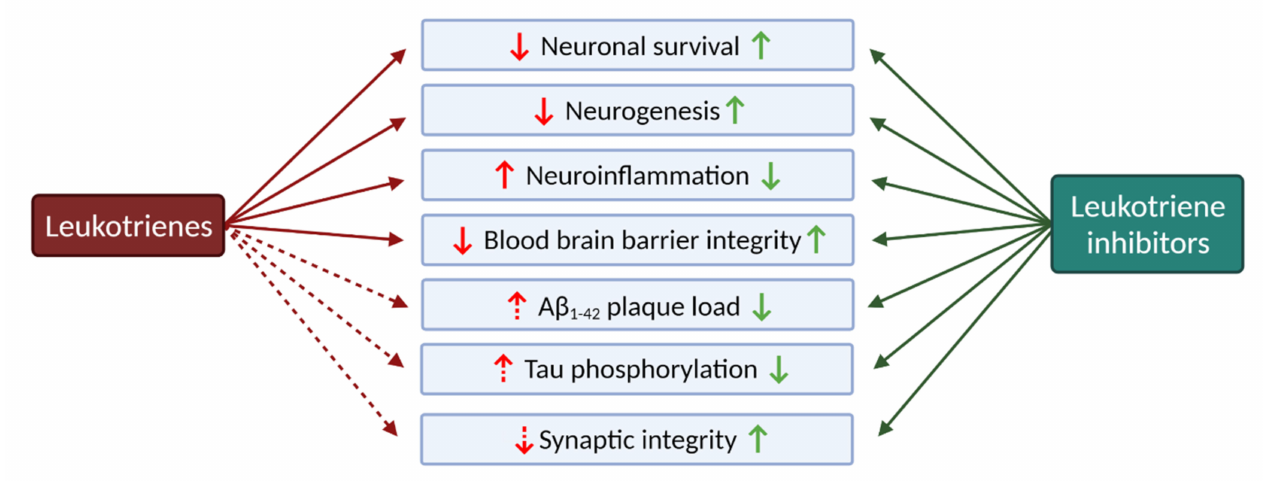
Figure 4. Leukotrienes in the central nervous system: a pleiotropic effect. Broken lines symbolize putative actions of leukotriene signalling that require further investigations. Image adapted from Michael et al. [67], with permission from Elsevier. Created with